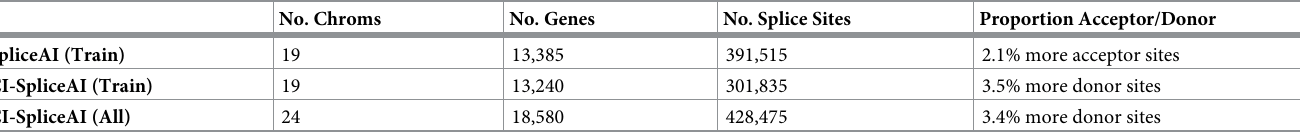
Table 1. Numeric comparison between the original SpliceAI training set and our novel collapsed dataset.